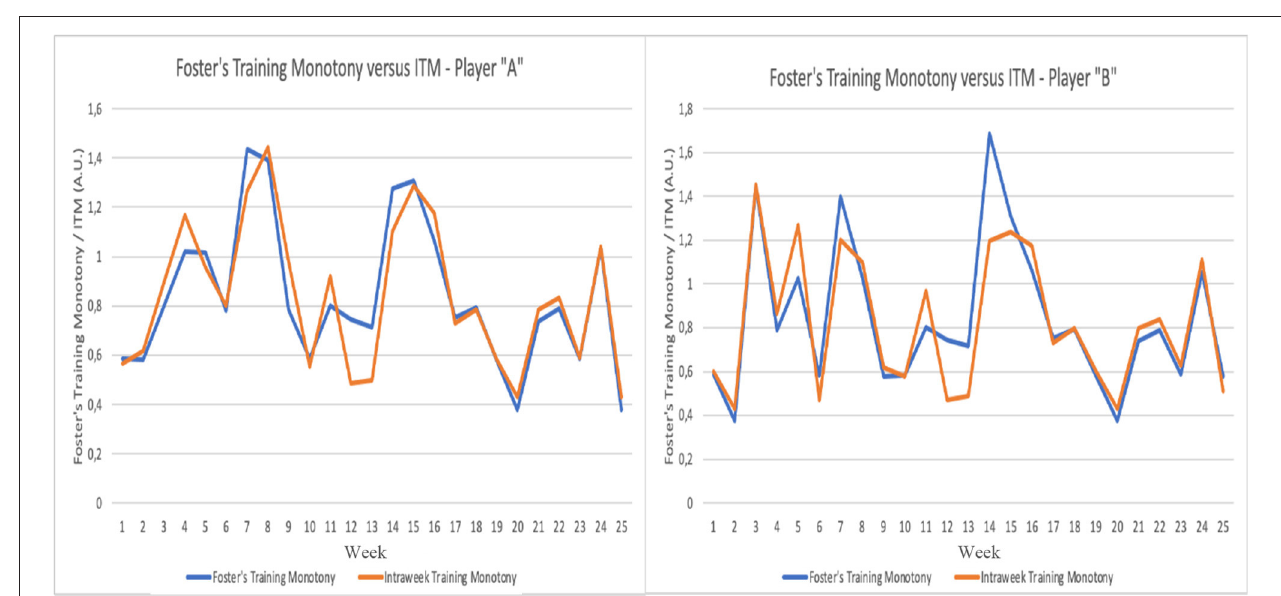
FIGURE 6 | Foster’s Training Monotony vs. Intraweek Training Monotony (ITM) for two selected players.